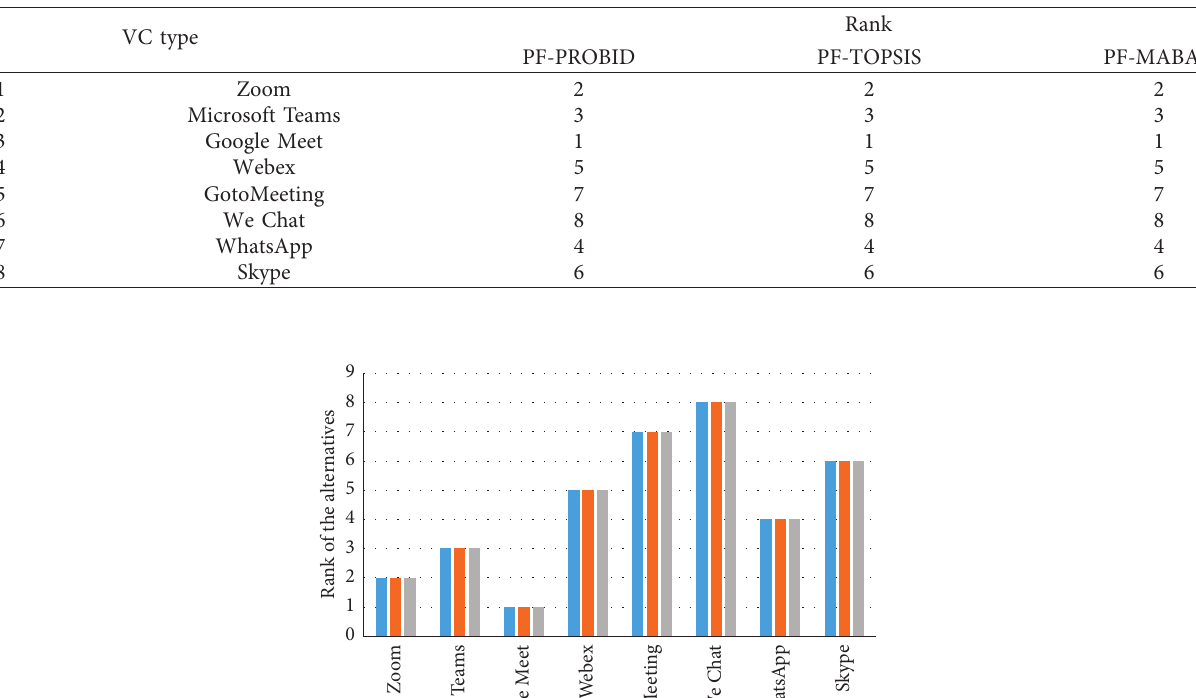
Table 15: Results of the comparative analysis of results.